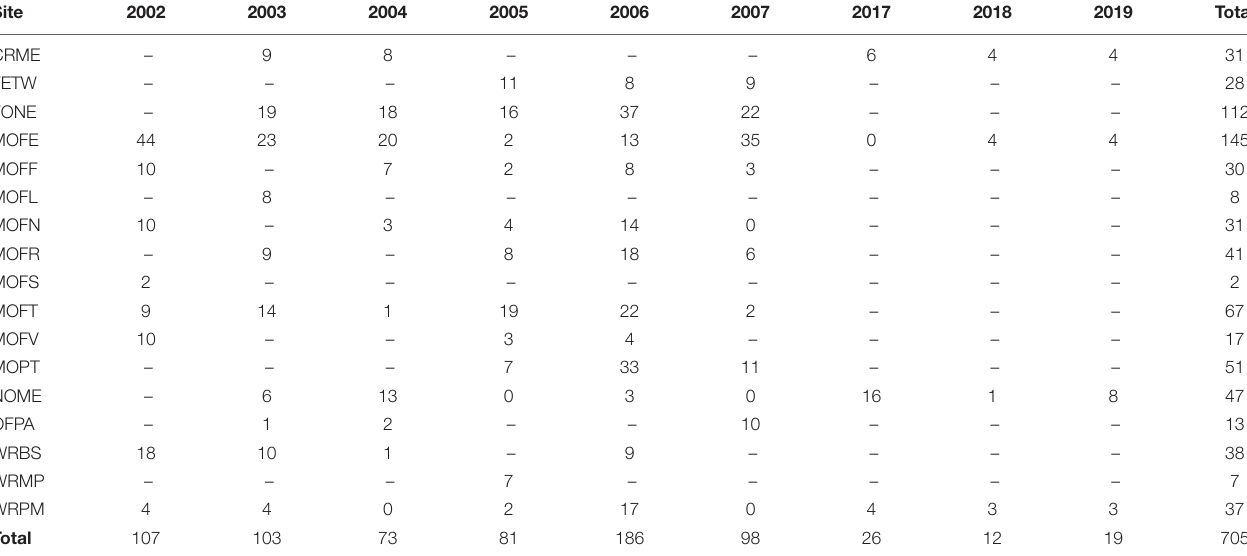
TABLE 5 | Adult dickcissel captures by site and